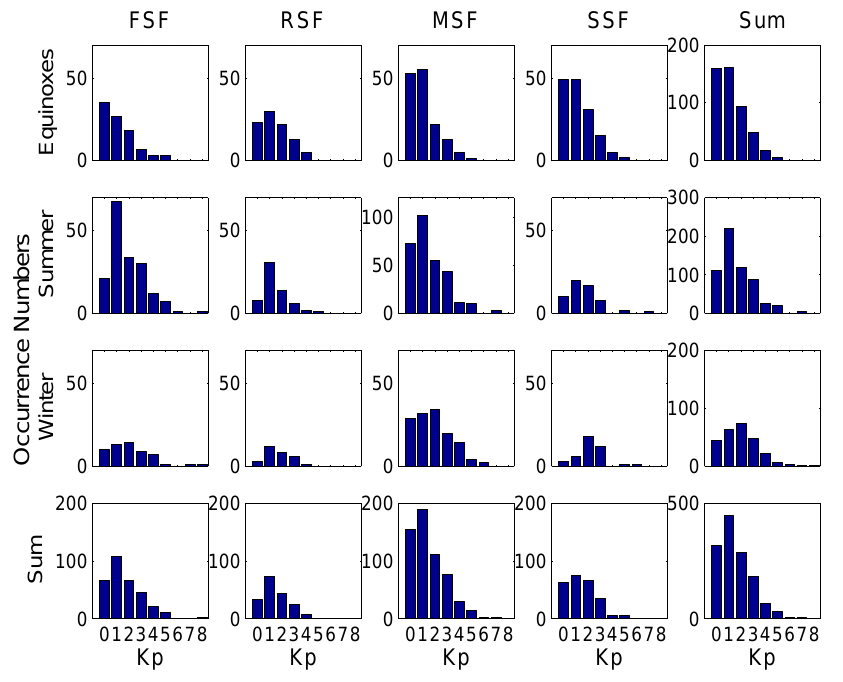
Fig. 5. Observed occurrence number of each type SF at Hainan station in the different seasons from March 2002 to February 2008 plotted as a function of kp determined as the average during the 6 h prior to sunset, i.e., about 14:00–20:00LT (LT=UT+8). The sum numbers of column, row and total of SF are also